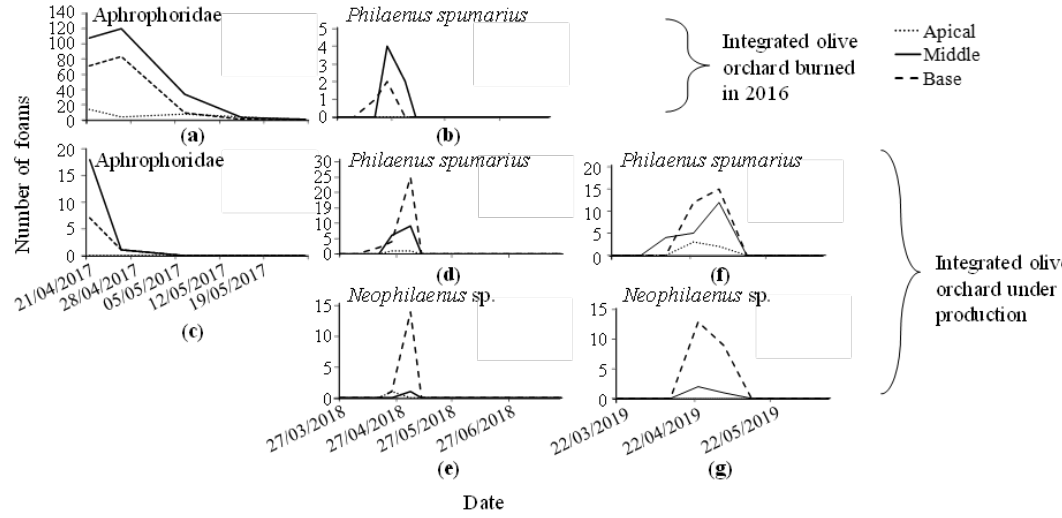
Figure 6. Number of Aphrophoridae foams in the apical, middle, or base part of the host plant in an abandoned olive orchard (UNP) during the sampled dates: ( a ) Aphrophoridae, year 2017 and ( b ) Philaenus spumarius , year 2018; and a productive olive orchard (P): ( c ) Aphrophoridae, year 2017, ( d ) P. spumarius , year 2018, ( e ) Neophilaenus sp., year 2019, ( f ) P. spumarius , year 2018, ( g ) Neophilaenus sp., year 2019.